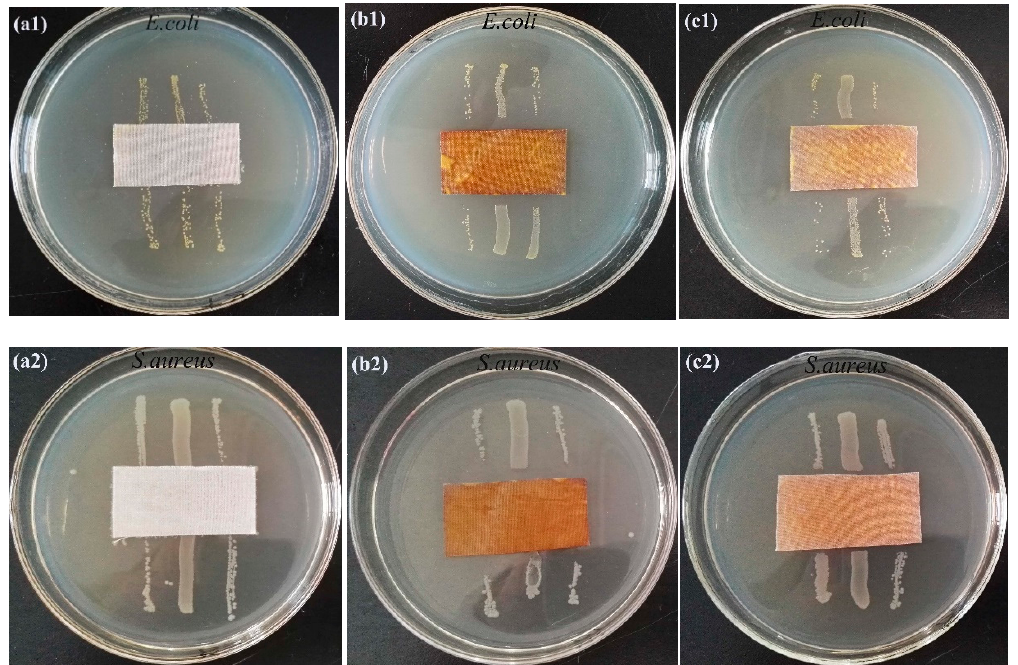
Figure 6. Antibacterial activities of different cotton fabrics ( a1 ): O-C; ( b1 ): PPA-C; ( c1 ): PPA-C after washing 10 cycles with Escherichia coli; and ( a2 ): O-C; ( b2 ): PPA-C; ( c2 ): PPA-C after washing 10 cycles with Staphylococcus aureus . Table 2. Antibacterial width of